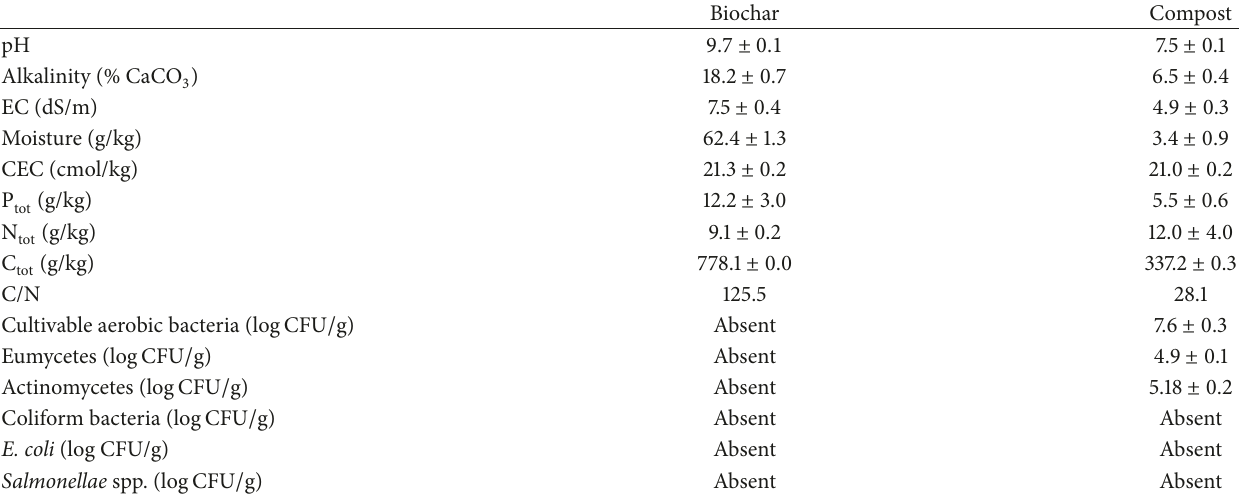
Table 1: Biochar and compost characteristics . The complete biochar and compost characterization and related methods are detailed in Amendola et al. [31] and Alfano et al. [30], respectively. All concentrations refer to dry matter and represent the means of three replicates ± standard